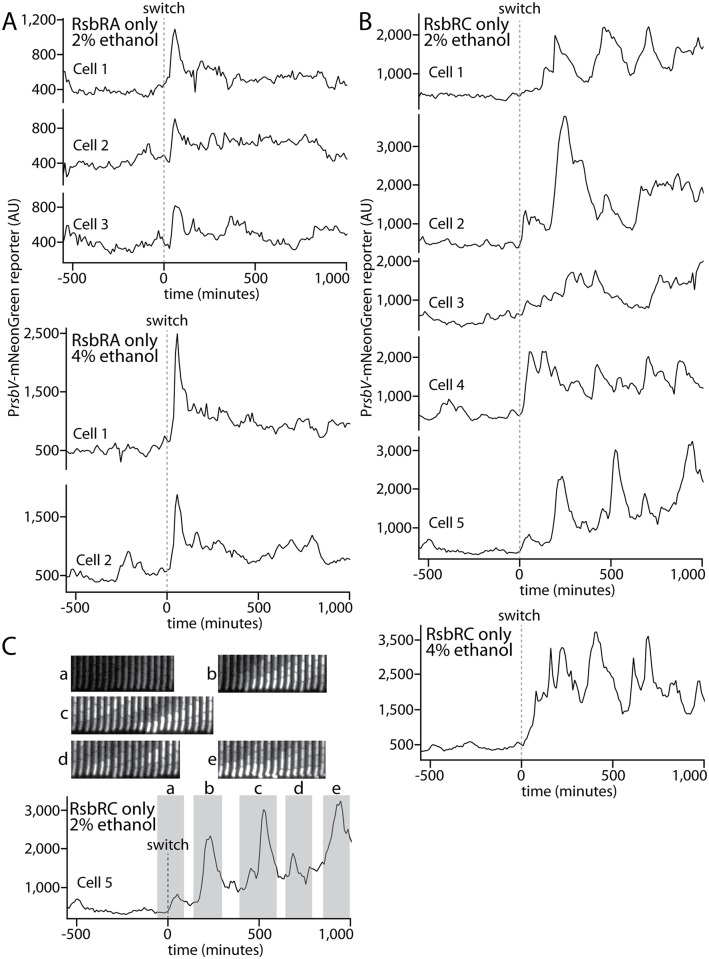
Individual cell lineages show stereotyped and stochastic response profiles in RsbRA-only and RsbRC-only strains, respectively.A. Intensity traces of a stress-responsive PrsbV-mNeonGreen reporter in an RsbRA-only strain (MTC1761) before and after (dashed line) the addition of ethanol at the indicated concentrations. Representative example cells are shown. B. Intensity traces as in A but with an RsbRC-only strain (MTC1765). Example cells were chosen to highlight the range of different observed responses. C. Annotated trace of Cell 5 from B with associated kymographs of the cells during response events.